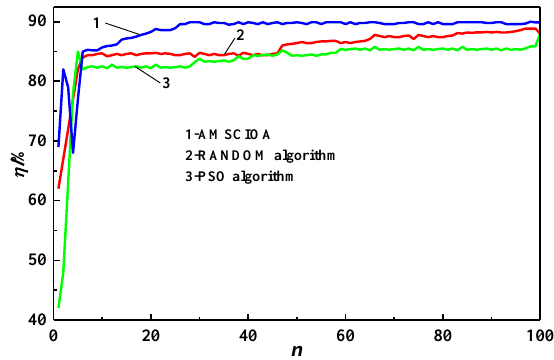
Figure 2. The detection rates (Noise level is 10%).